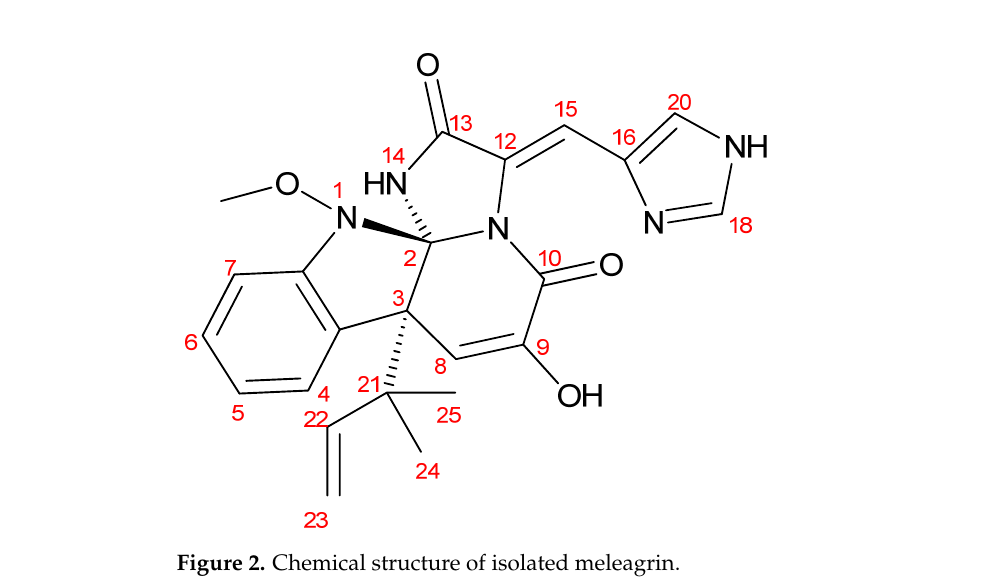
Figure 2. Chemical structure of isolated meleagrin.